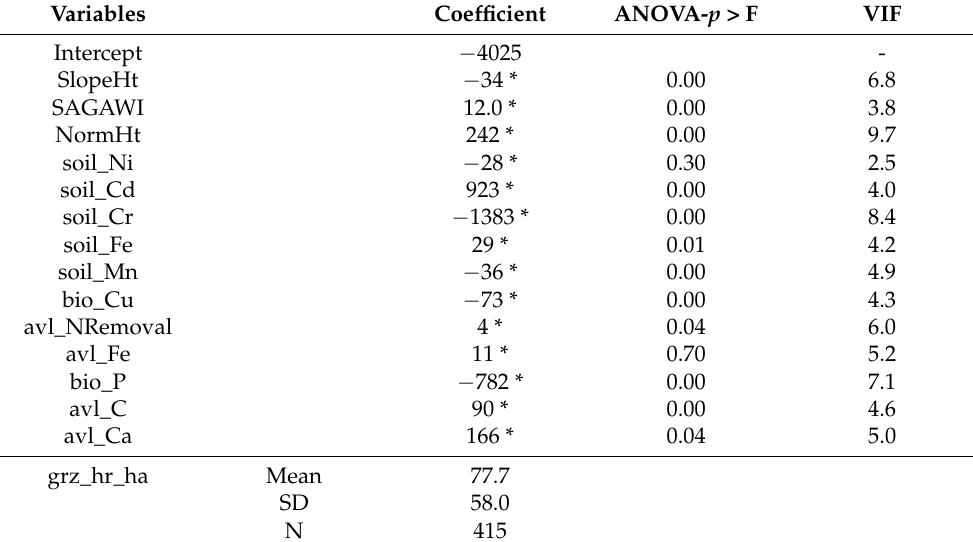
Table 2. Selected variables based on stepwise linear regression to model animal grazing hour, grz_hr_ha (h ha − 1 AU − 1 ) with their coefficients and variance inflation factor (VIF). Variables with VIF >10 were removed from the final model. At the bottom, mean, standard deviation and number of observation is summarized for grz_hr_ha